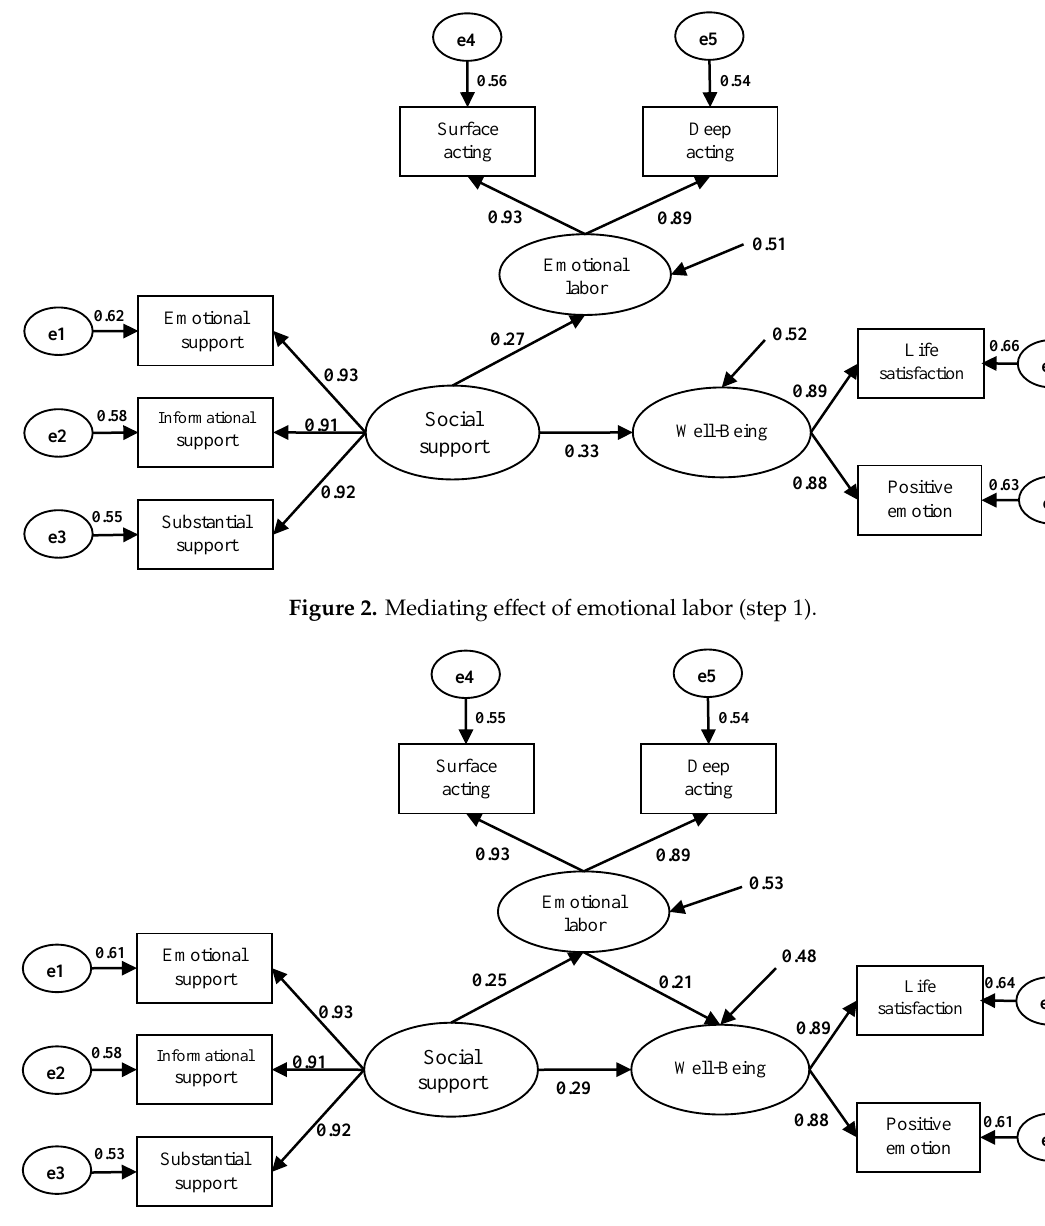
Table 4. Test of direct, indirect, overall effect and significance.